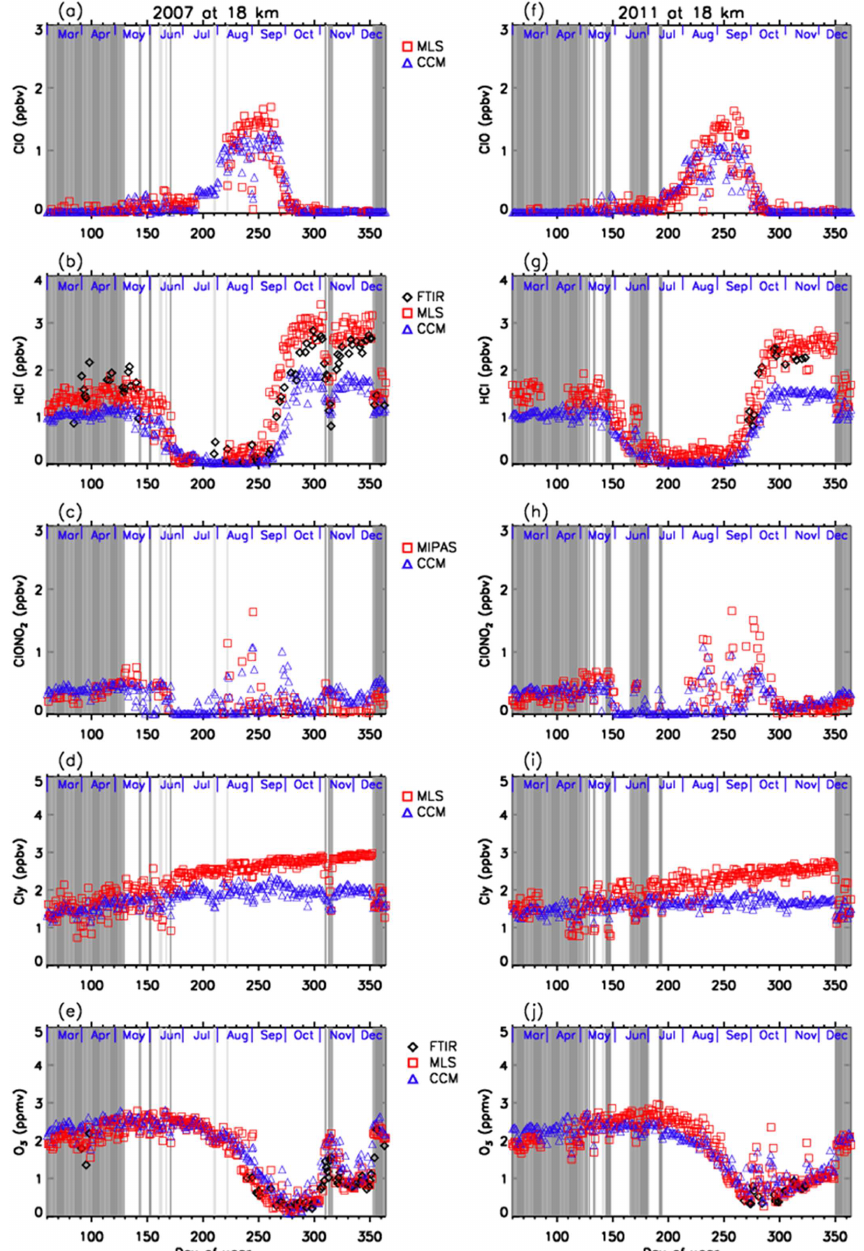
Figure 11. Daily time series of measured and modeled minor species over Syowa Station at 18km. Black diamonds are data by FTIR, red squares are by Aura MLS and Envisat MIPAS, blue triangles are data by MIROC3.2 CCM. Panel (a) is for ClO, (b) is for HCl, (c) is for ClONO 2 , (d) is for Cl y , and (e) is for O 3 in 2007. (f) is for ClO, (g) is for HCl, (h) is for ClONO 2 , (i) is for Cl y , and (j) is for O 3 in 2011.